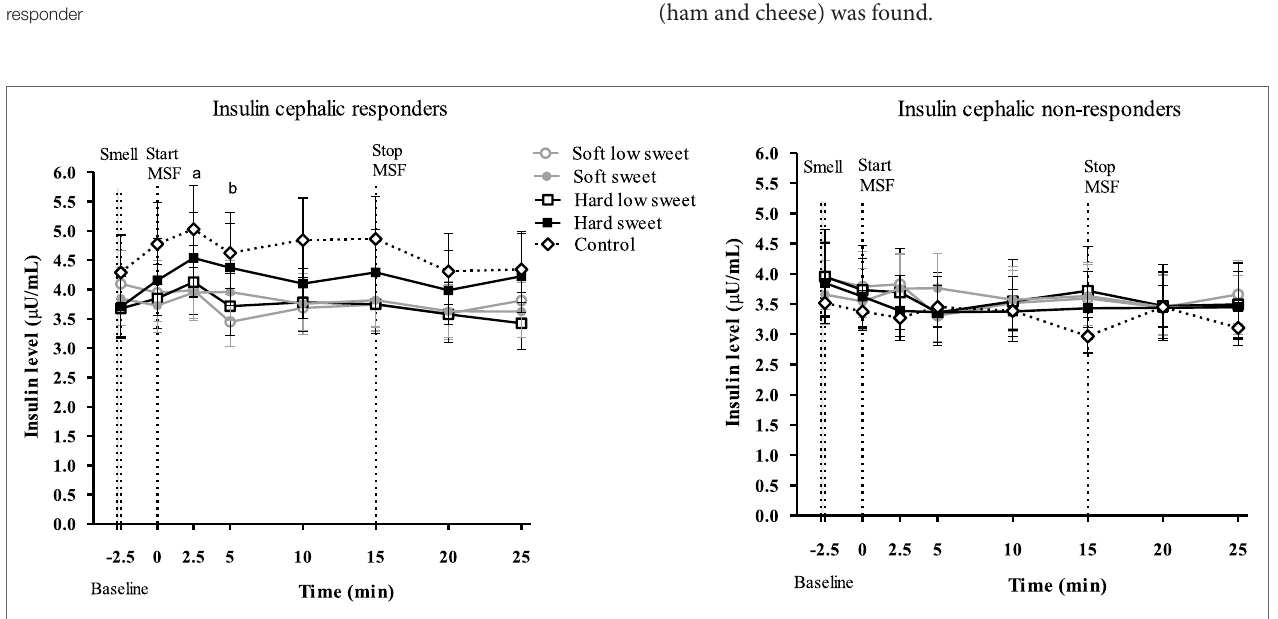
FigUre 9 | Geometric mean ± 95% CI insulin responder and non-responder curves. Letter “a” indicates a significant texture effect ( p = 0.049) and “b” indicates a significant sweetness effect ( p = 0.005).